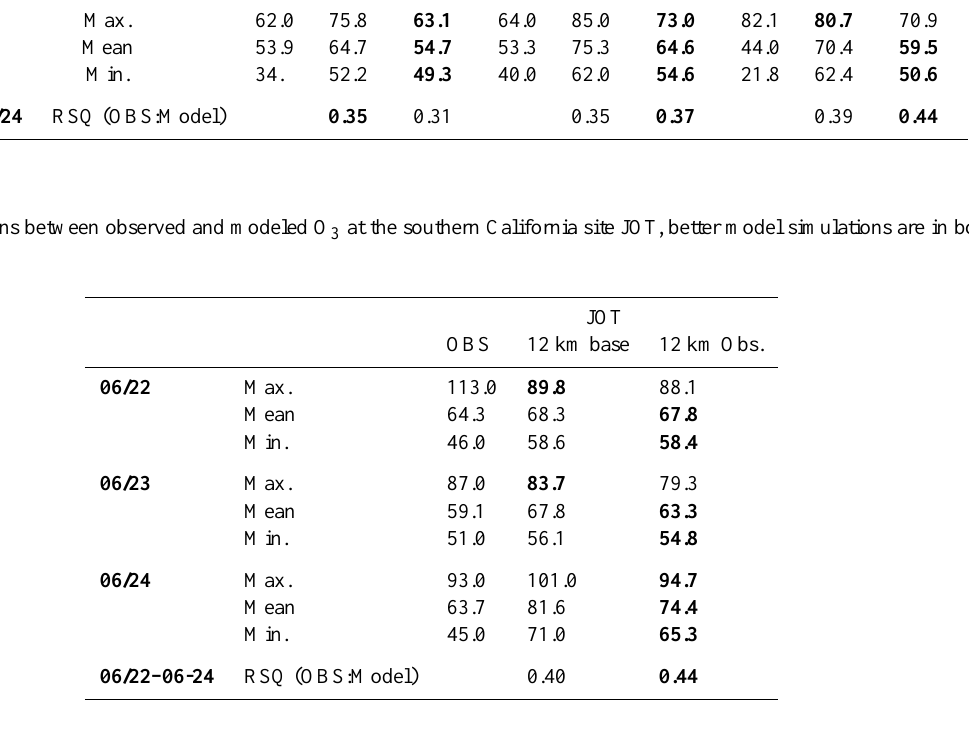
Table 3a. Comparisons between observed and modeled O 3 at three northern California sites, better model simulations are in bold (OBS- observations). TB LAV WGT OBS 60km 60km OBS 60km 60km OBS 60km 60km base Obs. base Obs. base Obs. 06/22 Max.